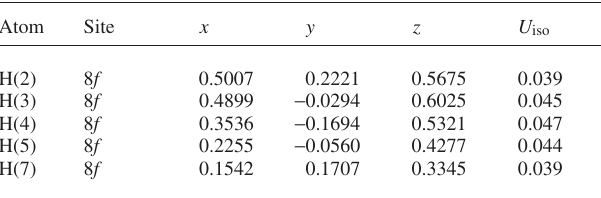
Table 2. Atomic coordinates and displacement parameters (in Å 2 ) . Table 2. Continued